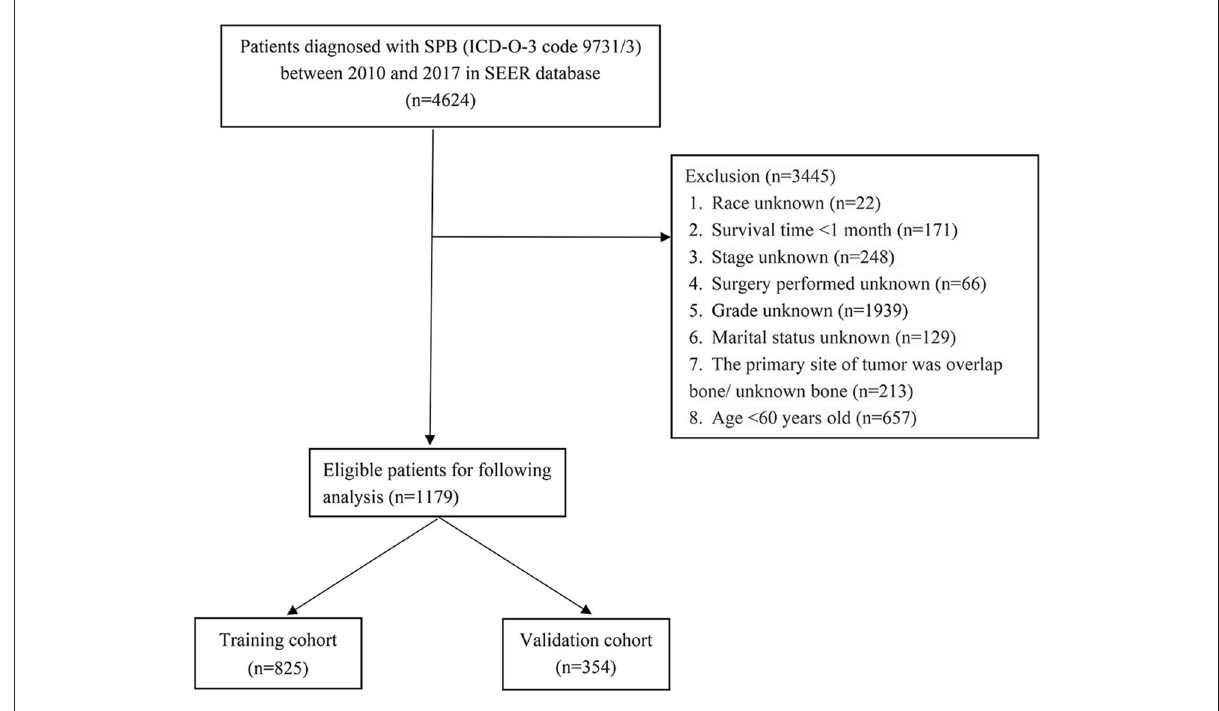
FIGURE1 The flowchart of including and dividing